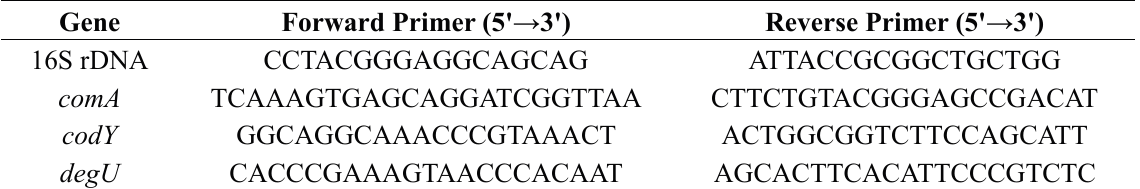
Table 3. Primers used for